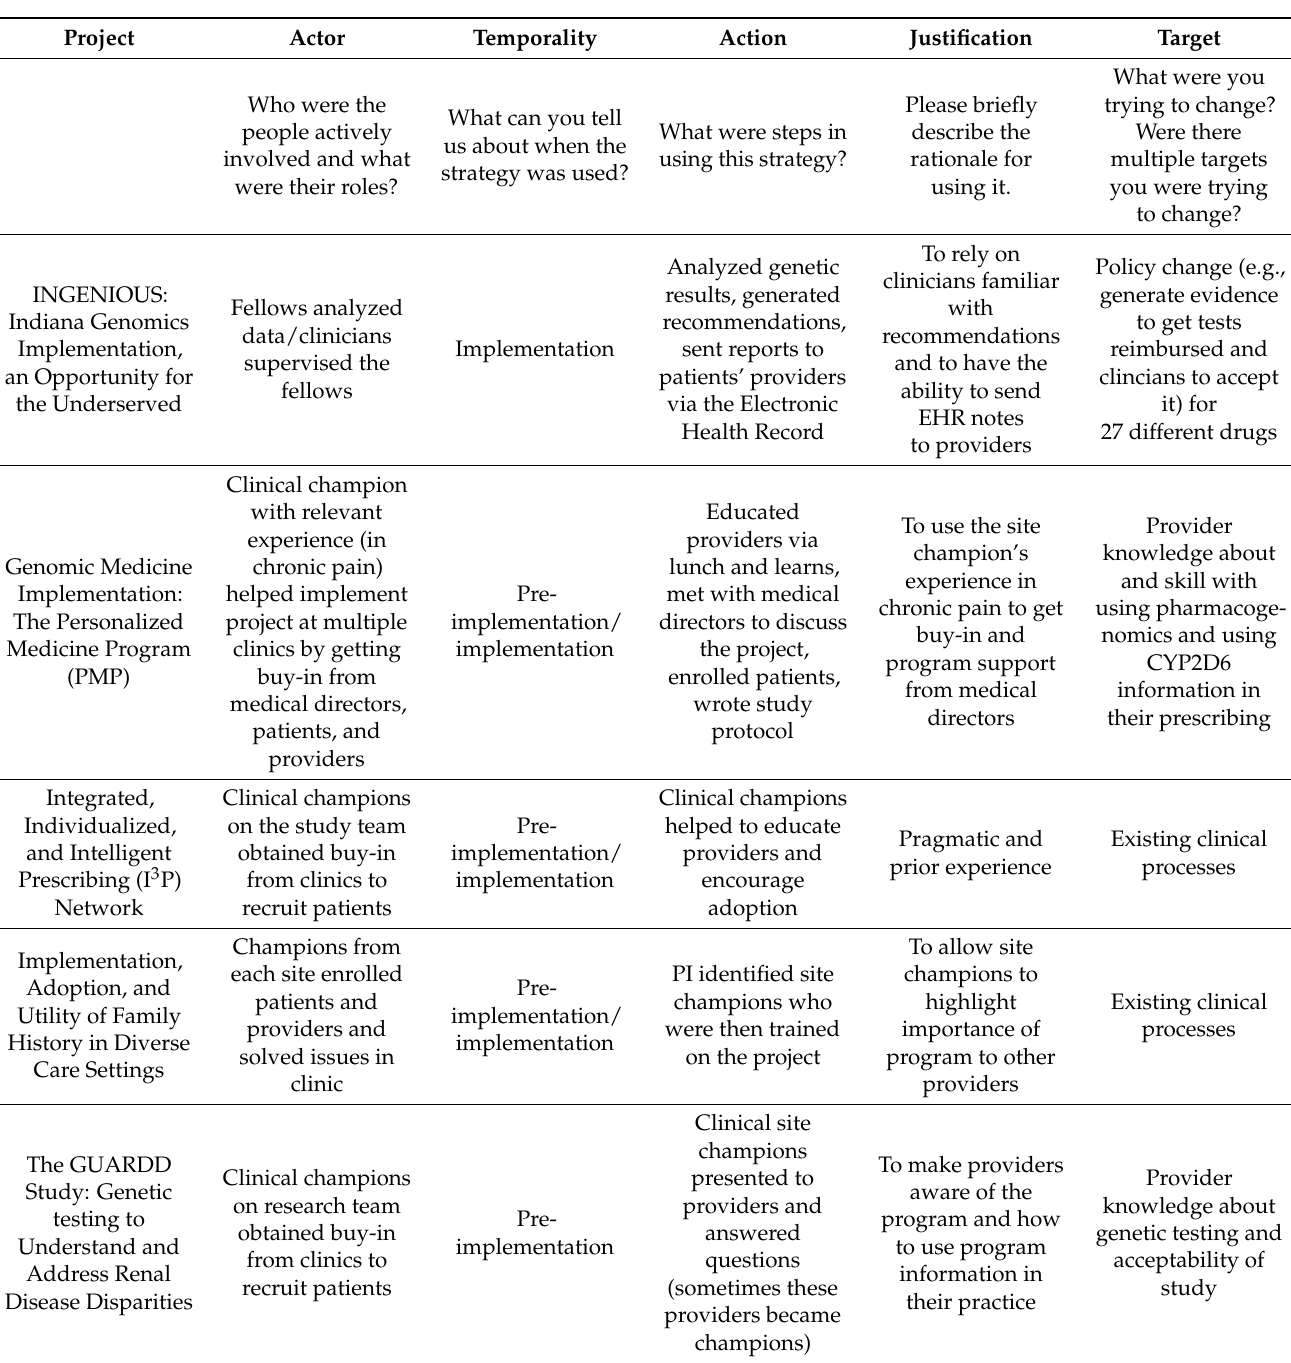
Table 2. Specification of “identifying early adopters” implementation strategy by IGNITE 1 genomic medicine implementa- tion